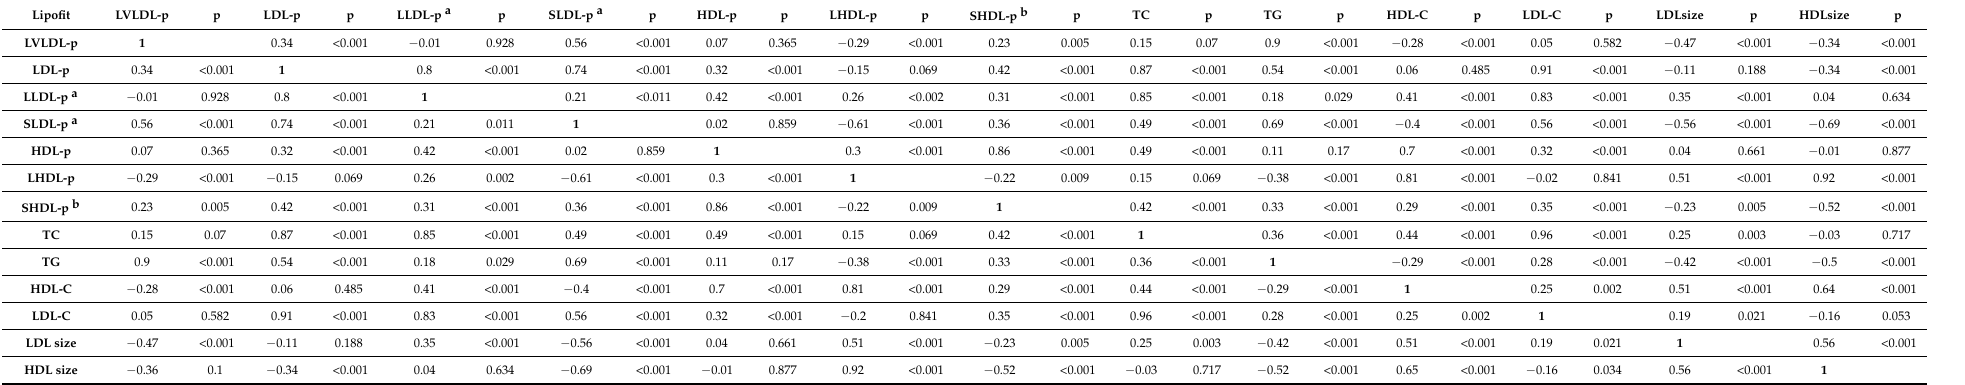
Table 2. Internal correlation matrix among lipids and lipoprotein particles for the lipofit method.